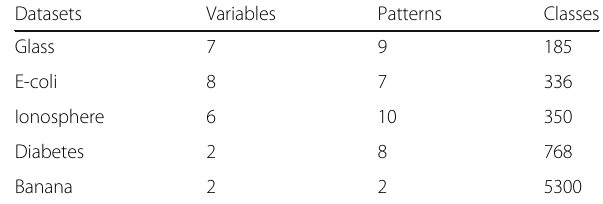
Table 3 Description of five selected machine learning